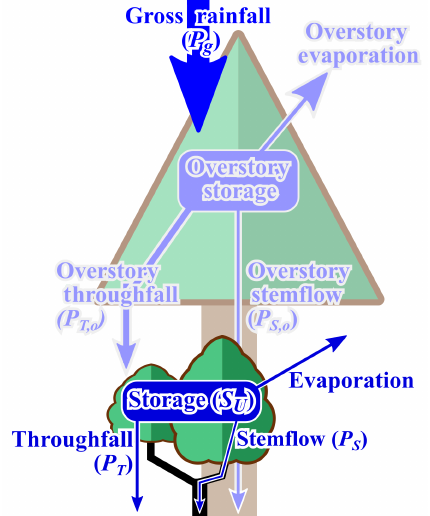
Figure 1. Partitioning of gross rainfall by the overstory (light blue) and the understory (dark blue). Overstory throughfall ( P T , o ), the input to the understory canopy, was estimated from past work at the site. In this study, overstory throughfall was modeled ( P (cid:48) Sect. 2.2.2), and maximum understory water storage capacity ( S U ), throughfall ( P T ) and stemflow ( P S ) were